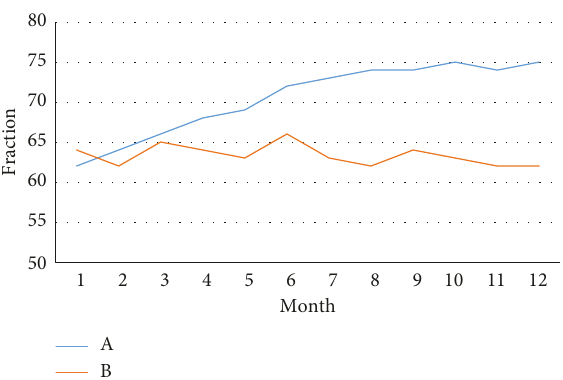
Figure 9: Changes in air quality in two cities A and B each month.